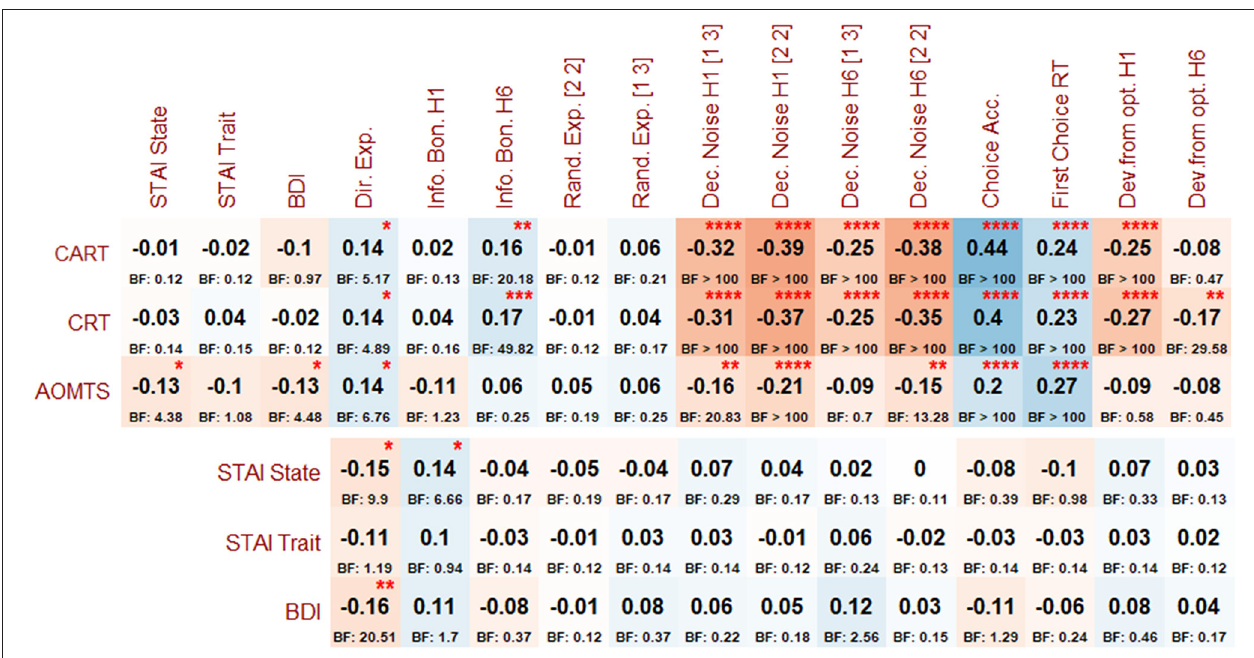
FIGURE 5 | Post-hoc correlations (and associated BFs) between reflectiveness measures, symptoms, and Horizon Task measures. Asterisks indicate BFs greater than 3, 10, 30, and 100, per conventional cutoffs for levels of evidence from moderate to extremely